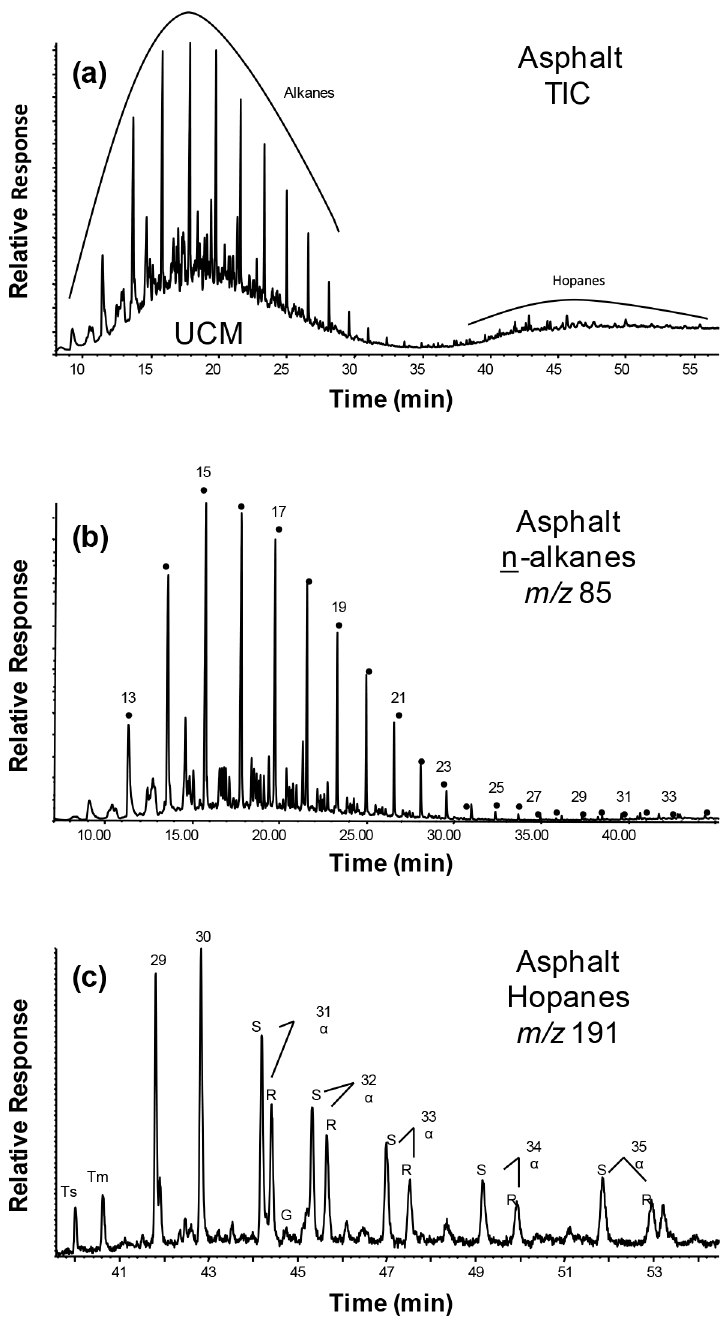
Fig 3. TIC trace showing the major organic tracers in the asphalt sample (a) and typical key ion plots for (b) n-alkanes and (c) hopanes.